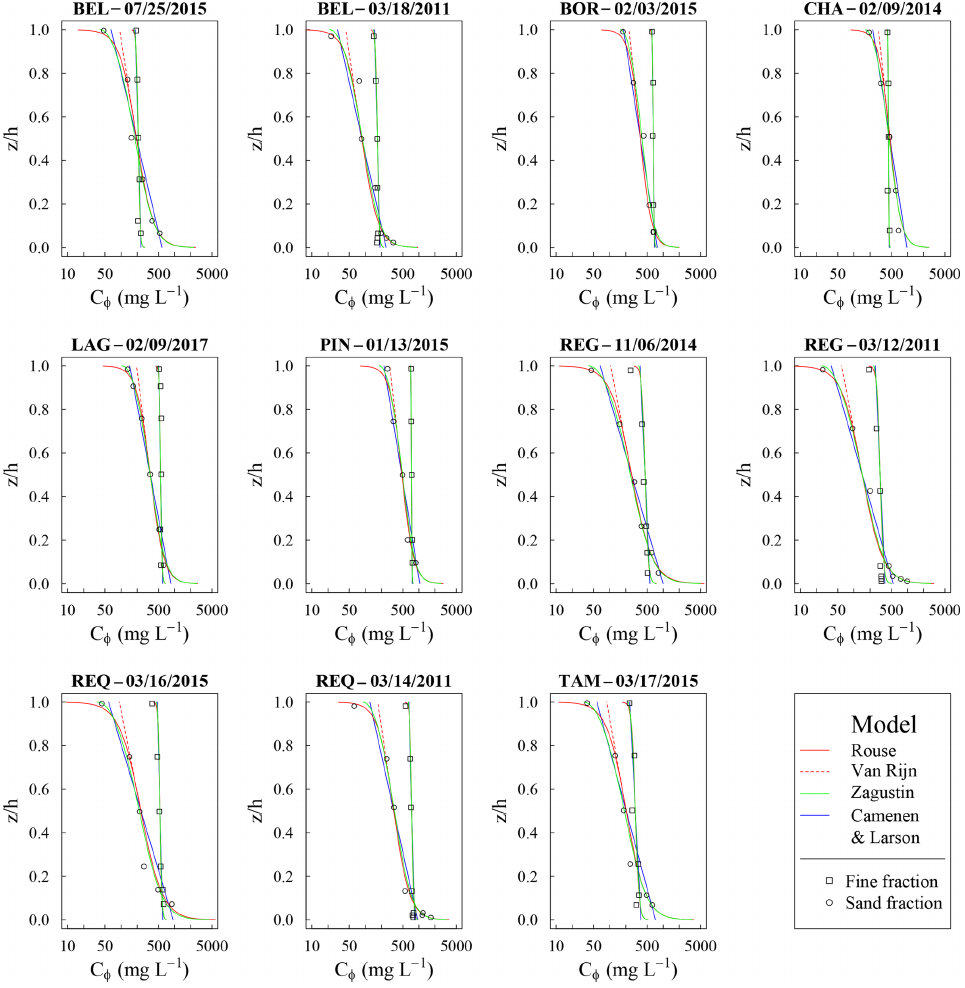
Figure 6. Typical examples of measured concentration profiles C φ ( z/h ), fitted with the Rouse, Van Rijn, Zagustin, and Camenen and Larson